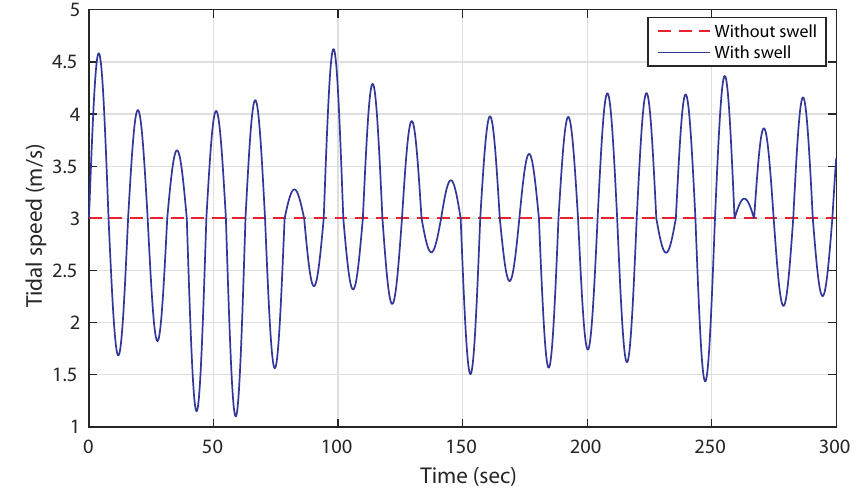
Figure 2. Tidal current speed profile with swell effect